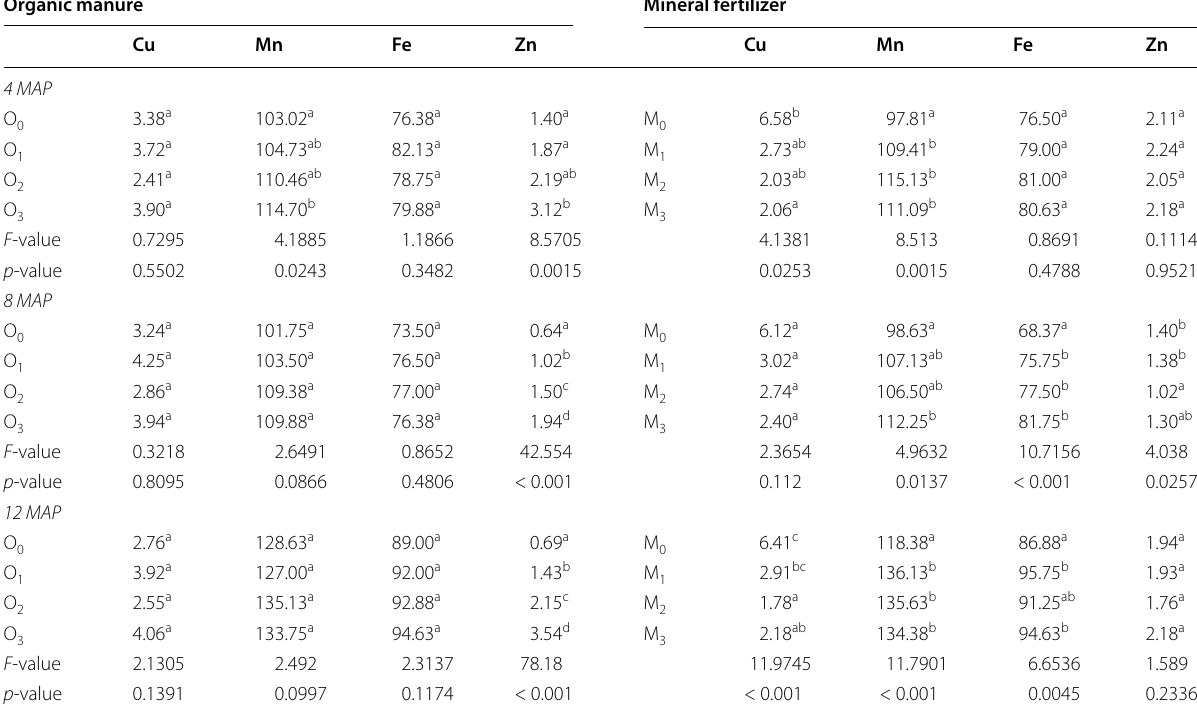
Table 4 Cassava fertilization effect on Cu, Mn, Fe, and Zn (all in mg kg − 1 ) over the three different sampling periods after planting at α 0.05 =